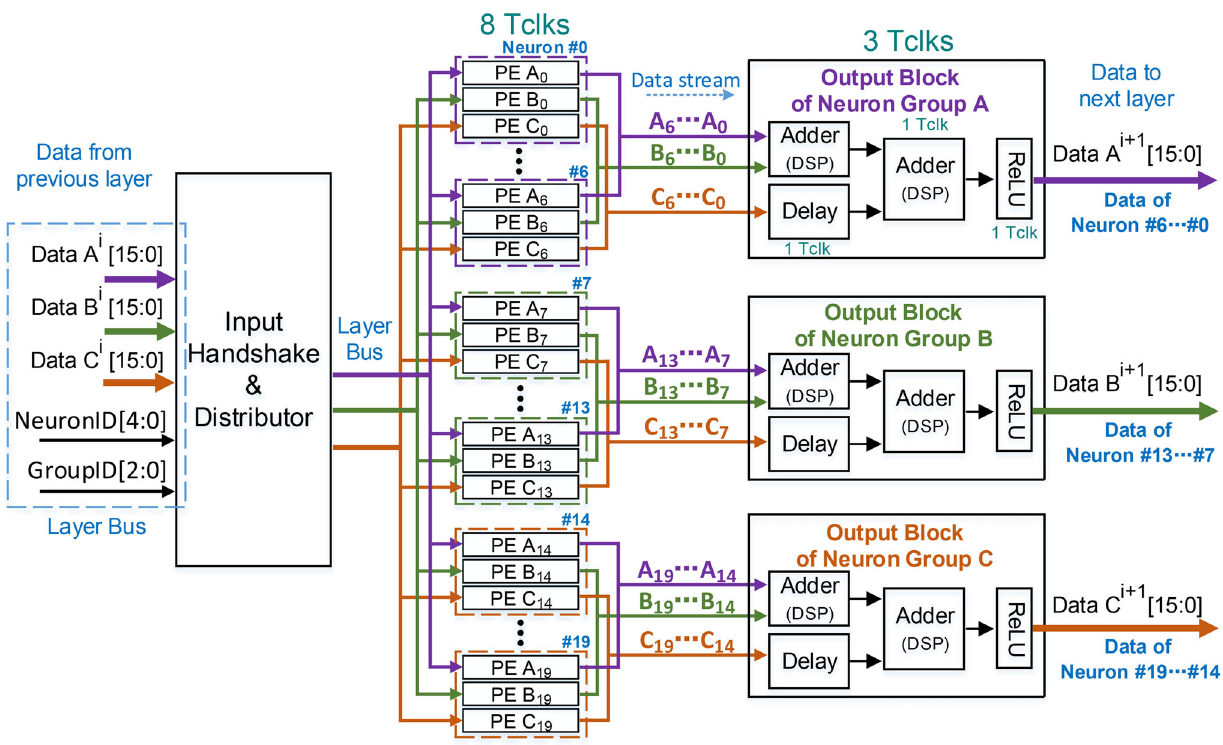
Fig. 13 FPGA logic design for one neuron layer